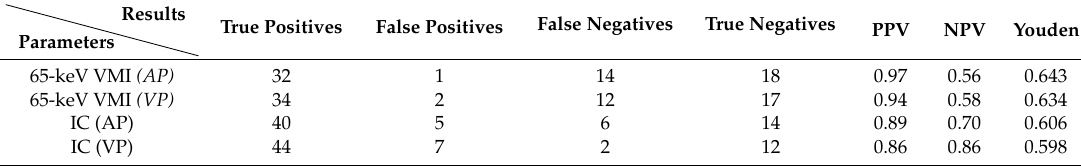
Table 4. Diagnoses of lung tumors on 65 keV VMI maps and IC (iodine concentration) maps in the arterial (AP) and venous (VP) contrast enhancement phase, respectively, based on the Youden index of ROC